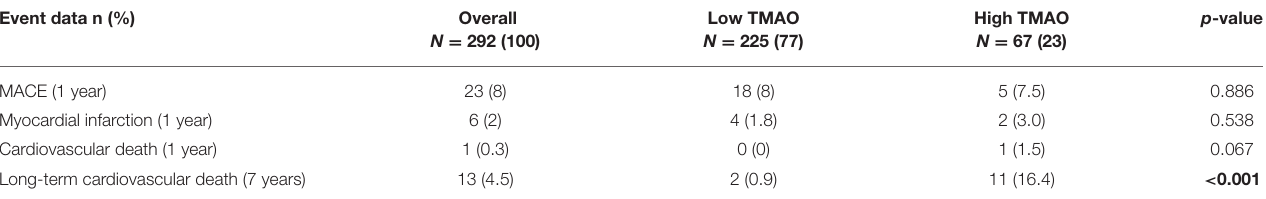
TABLE 4 | Event data.